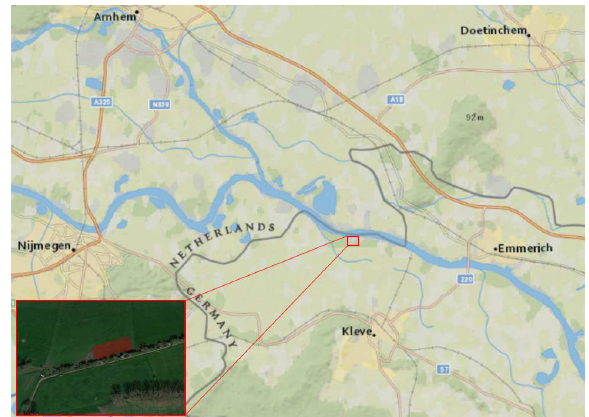
Figure 3. Grassland field locate in the Salmorth reserve with Rumex infestation located along the river Rhine to the West of the city of Emmerich next to the Dutch-German border.